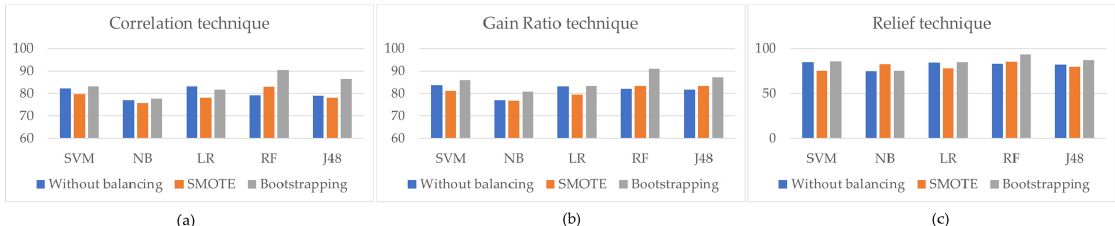
Figure 5. Accuracy of the classifiers for different feature selection techniques: ( a ) Comparing out- comes with the correlation method; ( b ) Comparing outcomes with the gain ratio method; and ( c ) Comparing outcomes with the relief method.